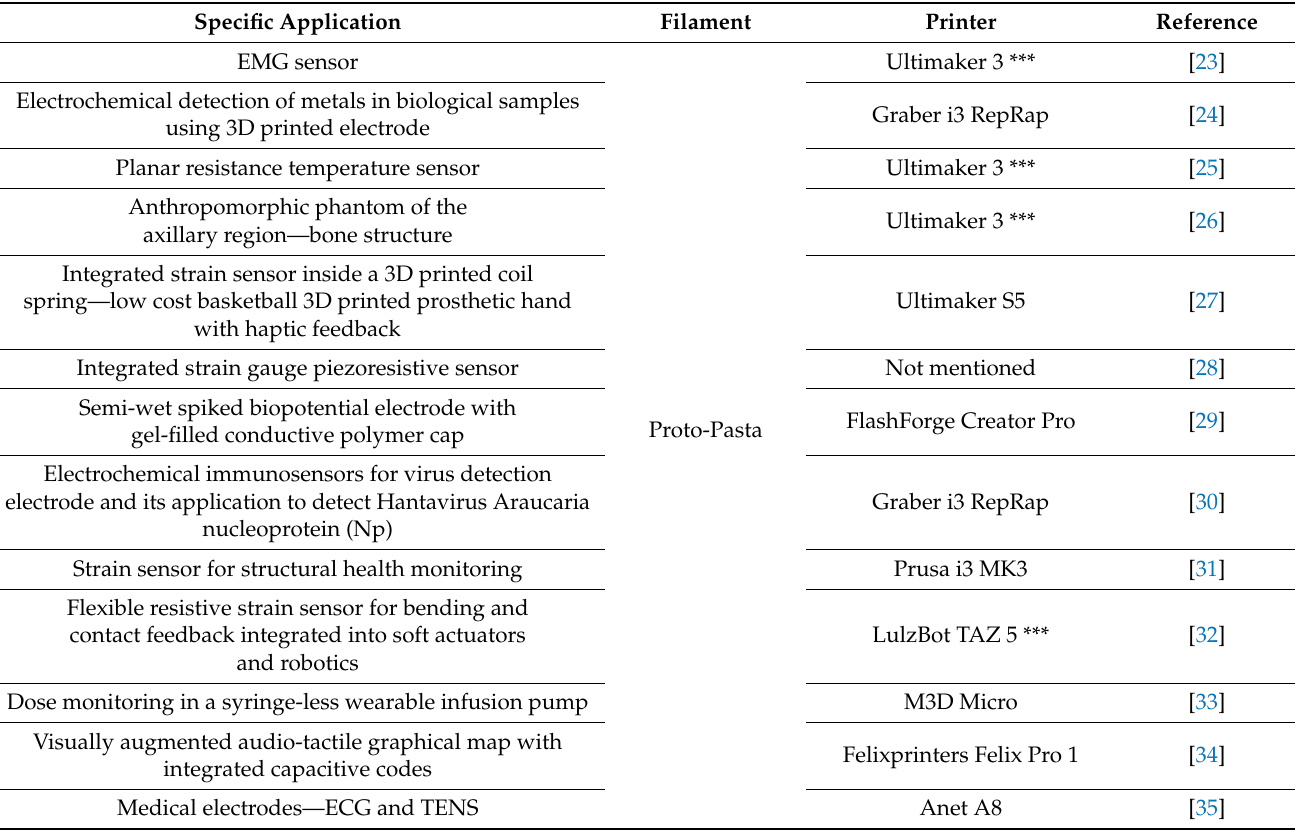
Figure 2. Physical defects of the printed samples for the following conductive filaments: ( a ) Proto- Pasta; ( b ) Filoalfa Alfaohm; ( c ) Palmiga PI-ETPU 95-250; ( d ) Multi3D Electrifi; ( e ) Conductive Filaflex; ( f ) Sunlu ABS; ( g ) Amolen; ( h ) 3dkonductive. Table 4. Medical applications articles that used conductive